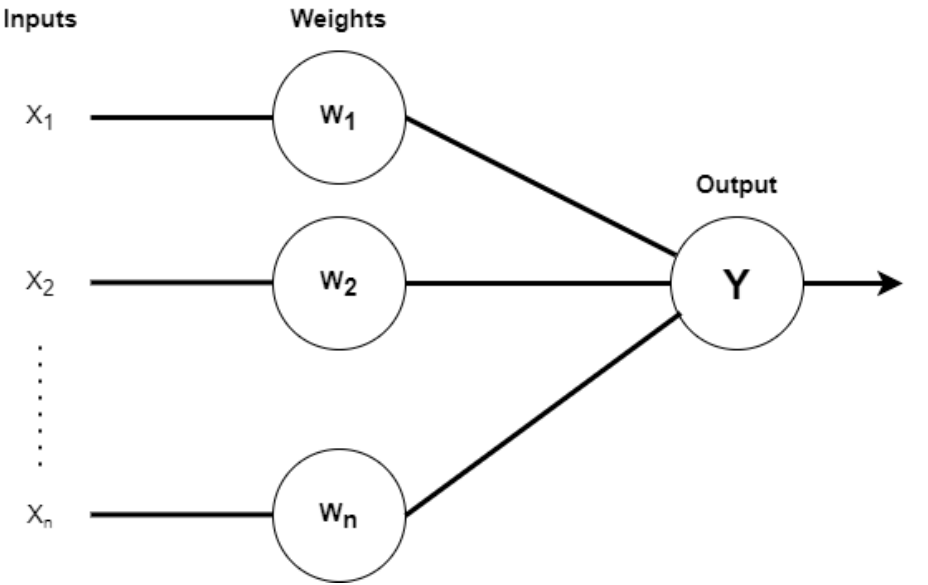
Figure 6. Single-layer perceptron and its operations.